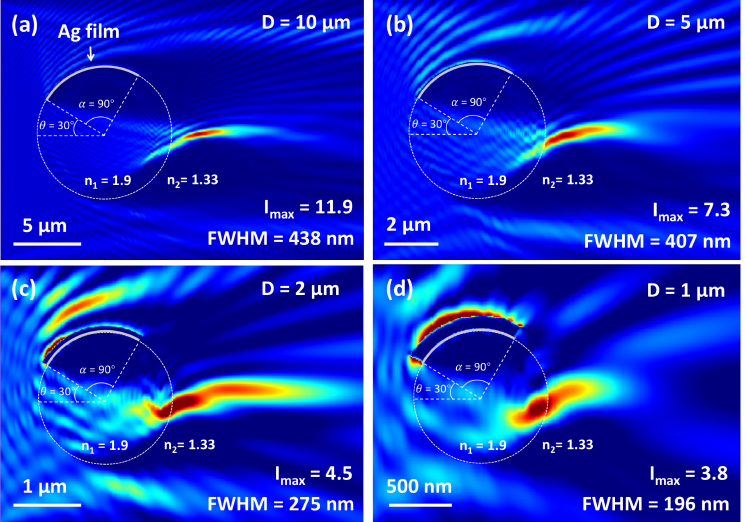
Figure 6. Optical fields of the patchy microcylinders with α = 90 ◦ and θ = 30 ◦ . The diameter of the cylinder is ( a ) 10 µ m, ( b ) 5 µ m, ( c ) 2 µ m and ( d ) 1 µ m,